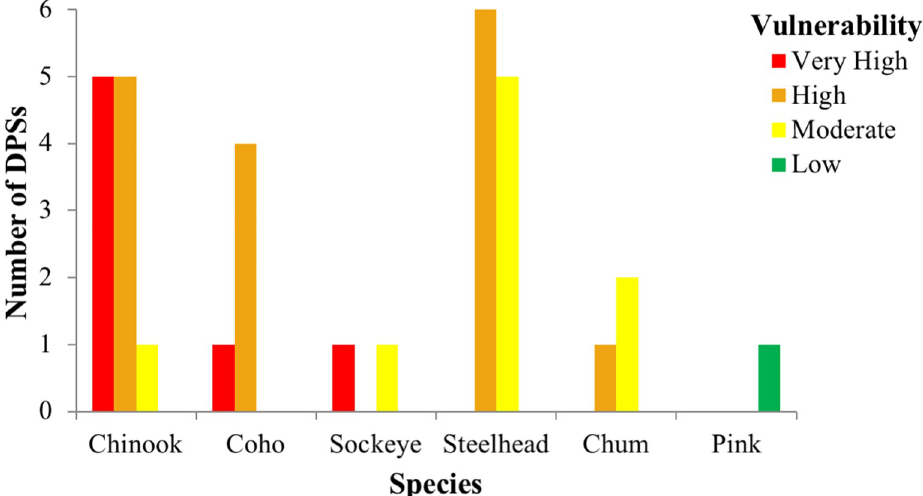
Fig 4. Number of DPSs in each vulnerability rank by